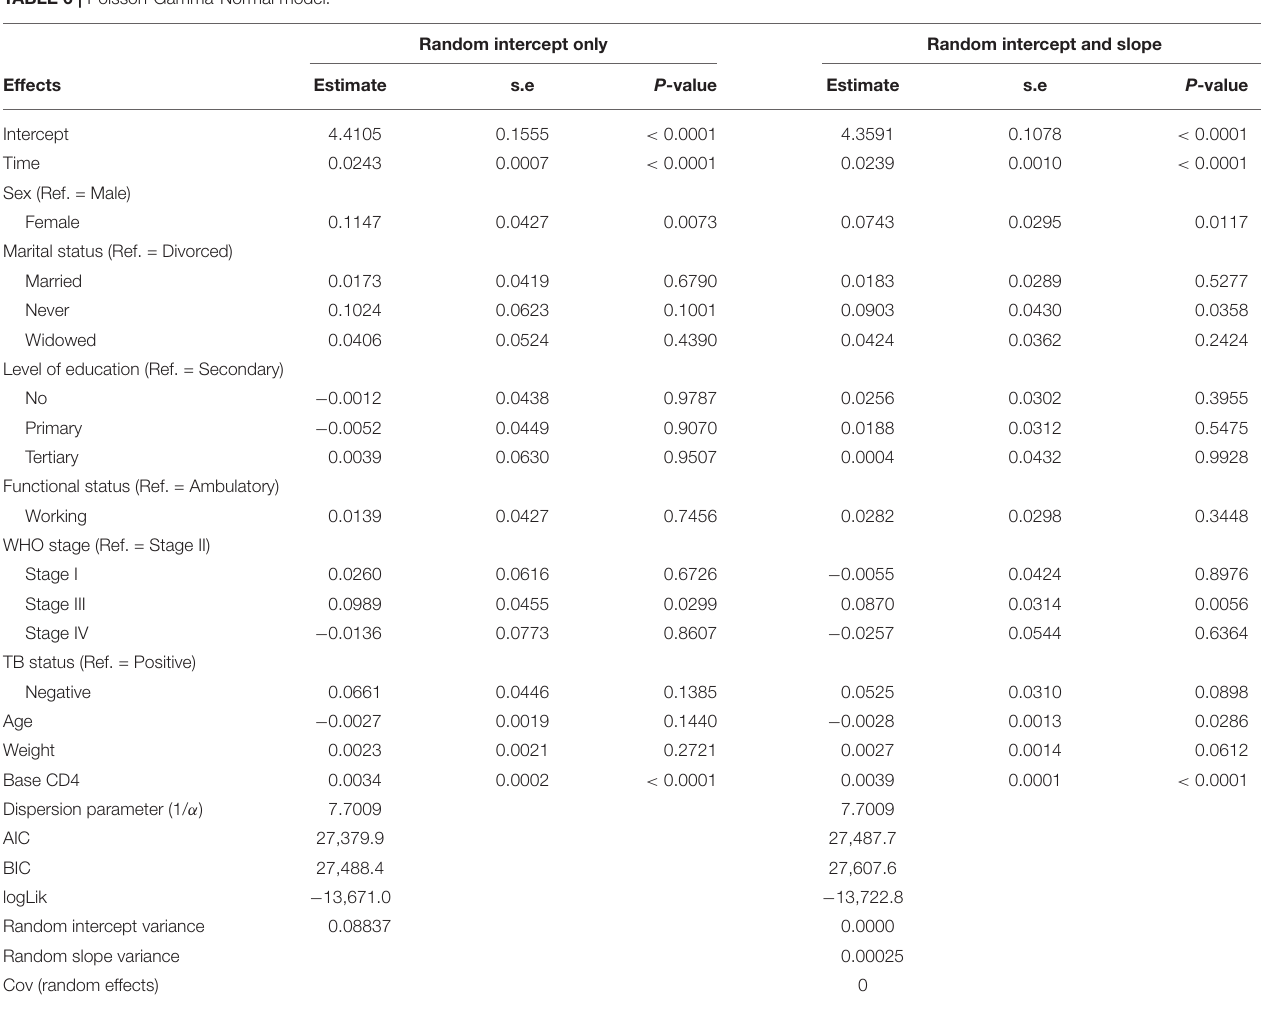
TABLE 6 | Poisson-Gamma-Normal